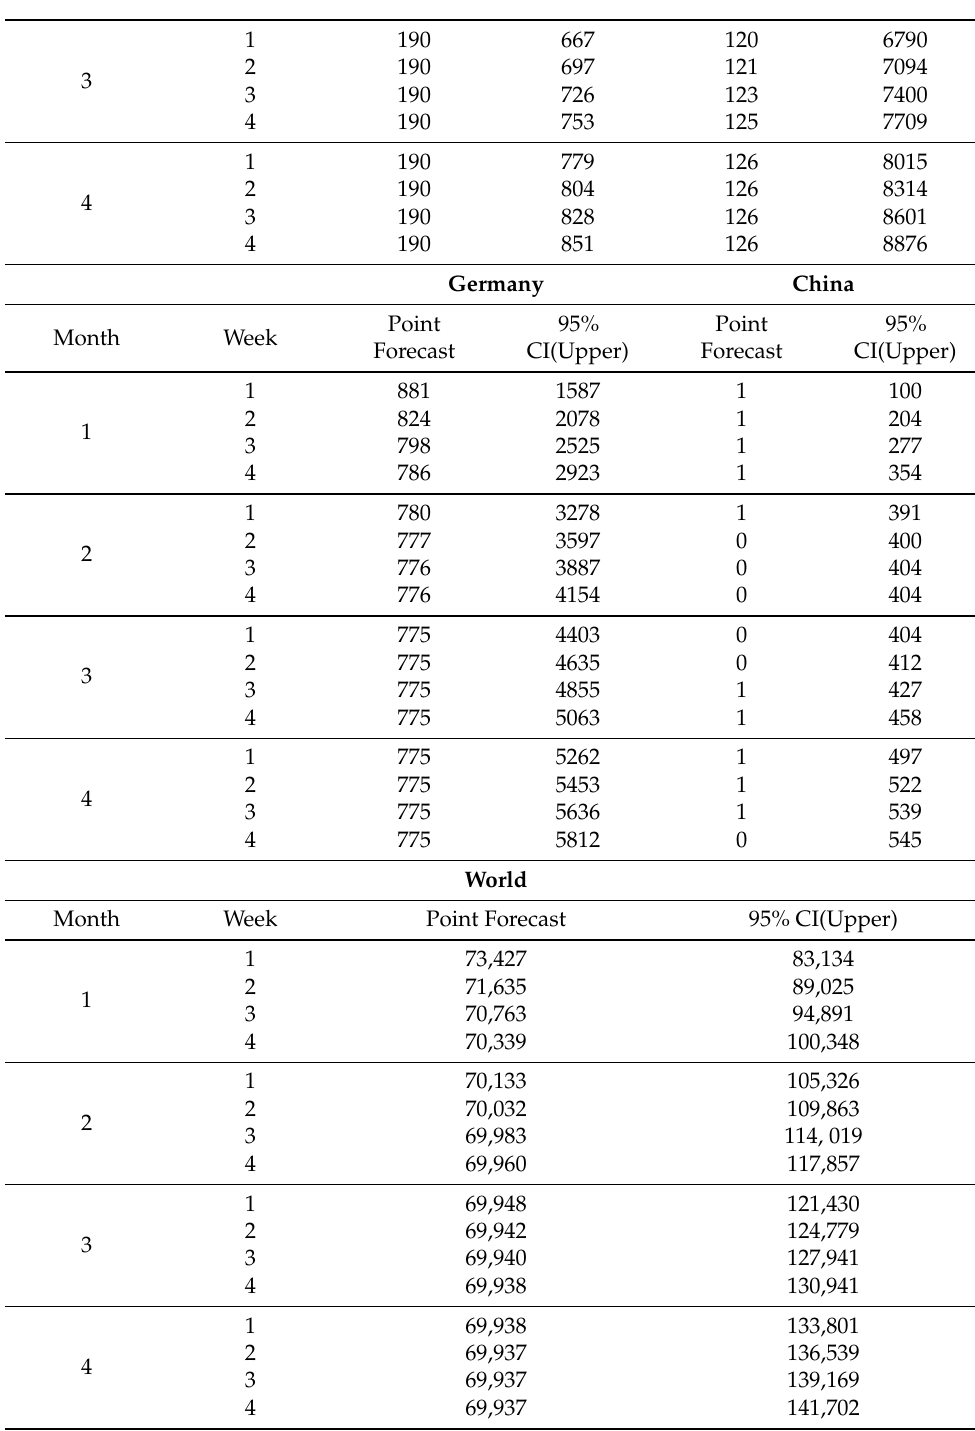
Figure 4 represents a detailed view of the number of weeks on the x-axis and the number of actual cases and predicted cases on the y-axis. Graph (A) shows the data from Bangladesh, graph (B) from China, graph (C) from Germany, graph (D) from India, graph (E) from Iran, graph (F) from Italy, graph (G) from Pakistan, and graph (H) shows the data from the United